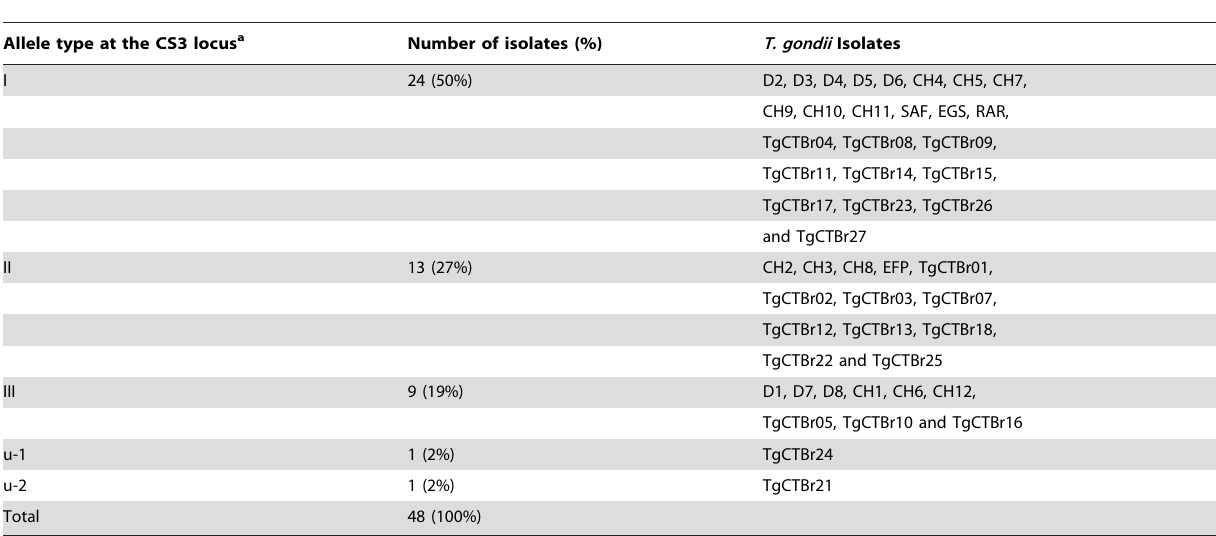
Table 2. Distribution of 48 Toxoplasma gondii isolates according to allele type at the CS3 locus.